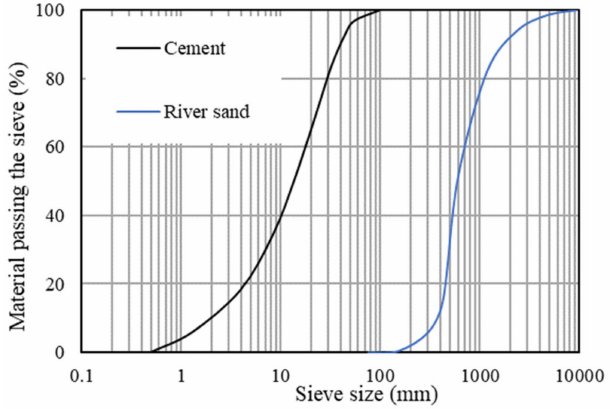
Figure 2. Particle size distribution of raw